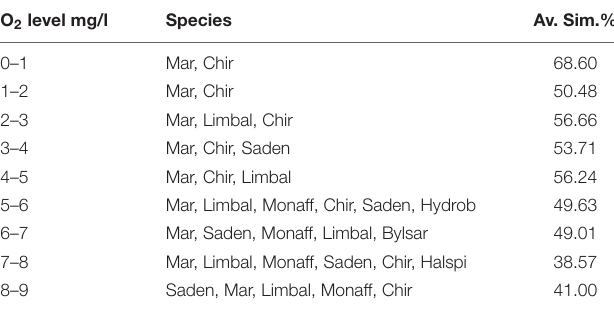
TABLE 3 | Zoobenthic species contributing to the similarity of assemblages defined by O 2 , and the average similarity (%) of assemblages in 9 different O